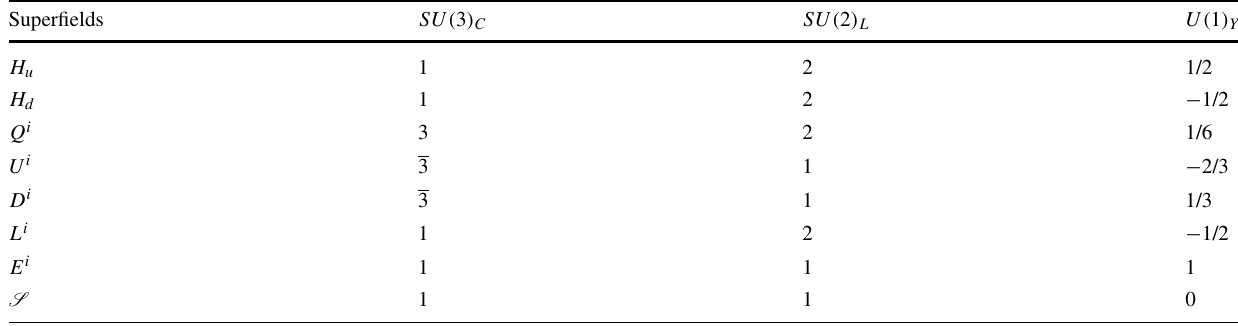
are SU ( 5 ) indices. We have suppressed the SU ( 5 ) indiceswhile writing